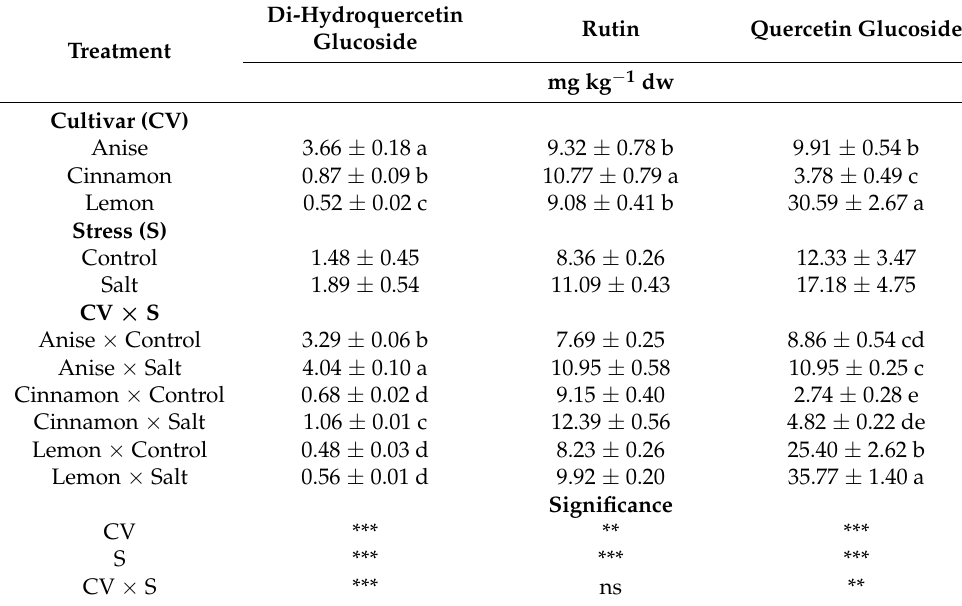
Table 4. Effect of basil cultivars (CV) and stress (S) on flavonoids